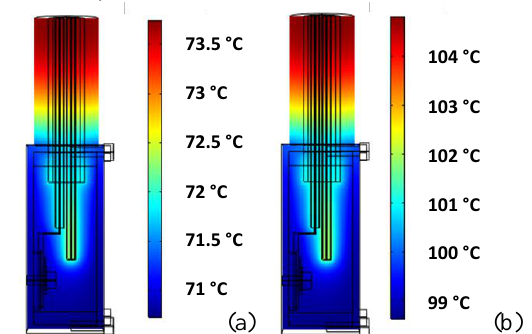
Fig. 3. Vertical cross section of the complete 3-D detector for nuclear heating rate values of 0.025 W·g -1 (a) and 0.055 W·g -1 (b) and a fluid temperature of 40